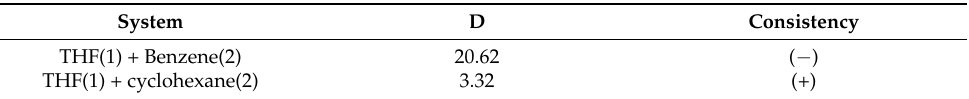
Table 4. The results of thermodynamic consistency test using the Herington test for the isothermal systems.